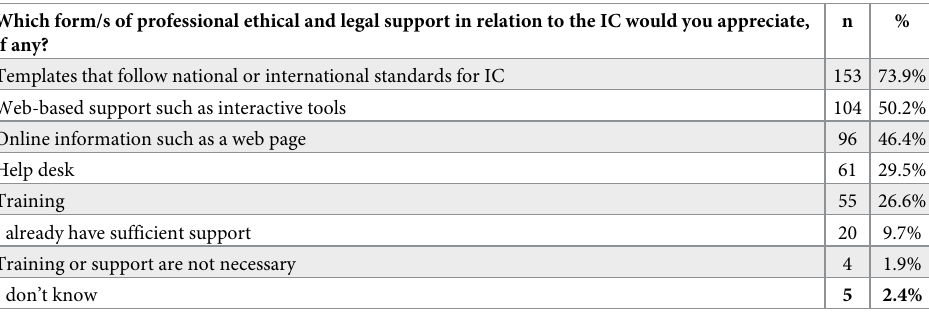
Table 11. Preferences for forms of professional ethical and legal support in relation to